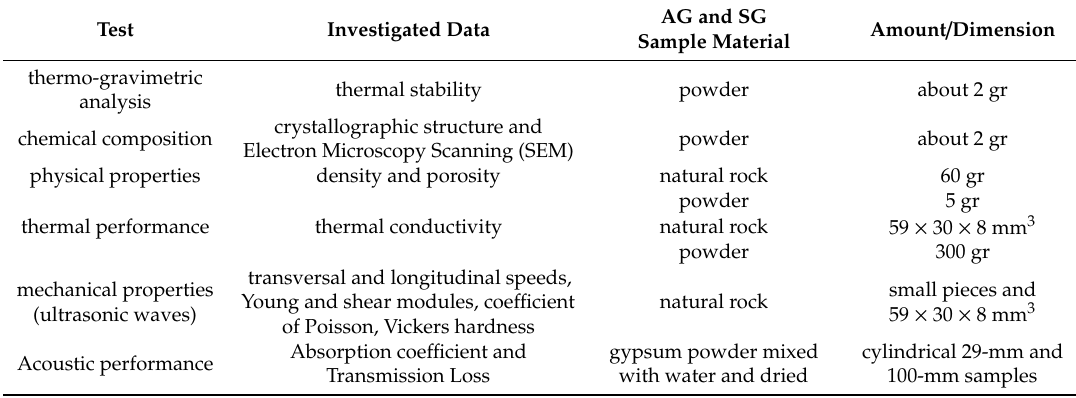
Table 1. Characteristics of the examined samples and the related